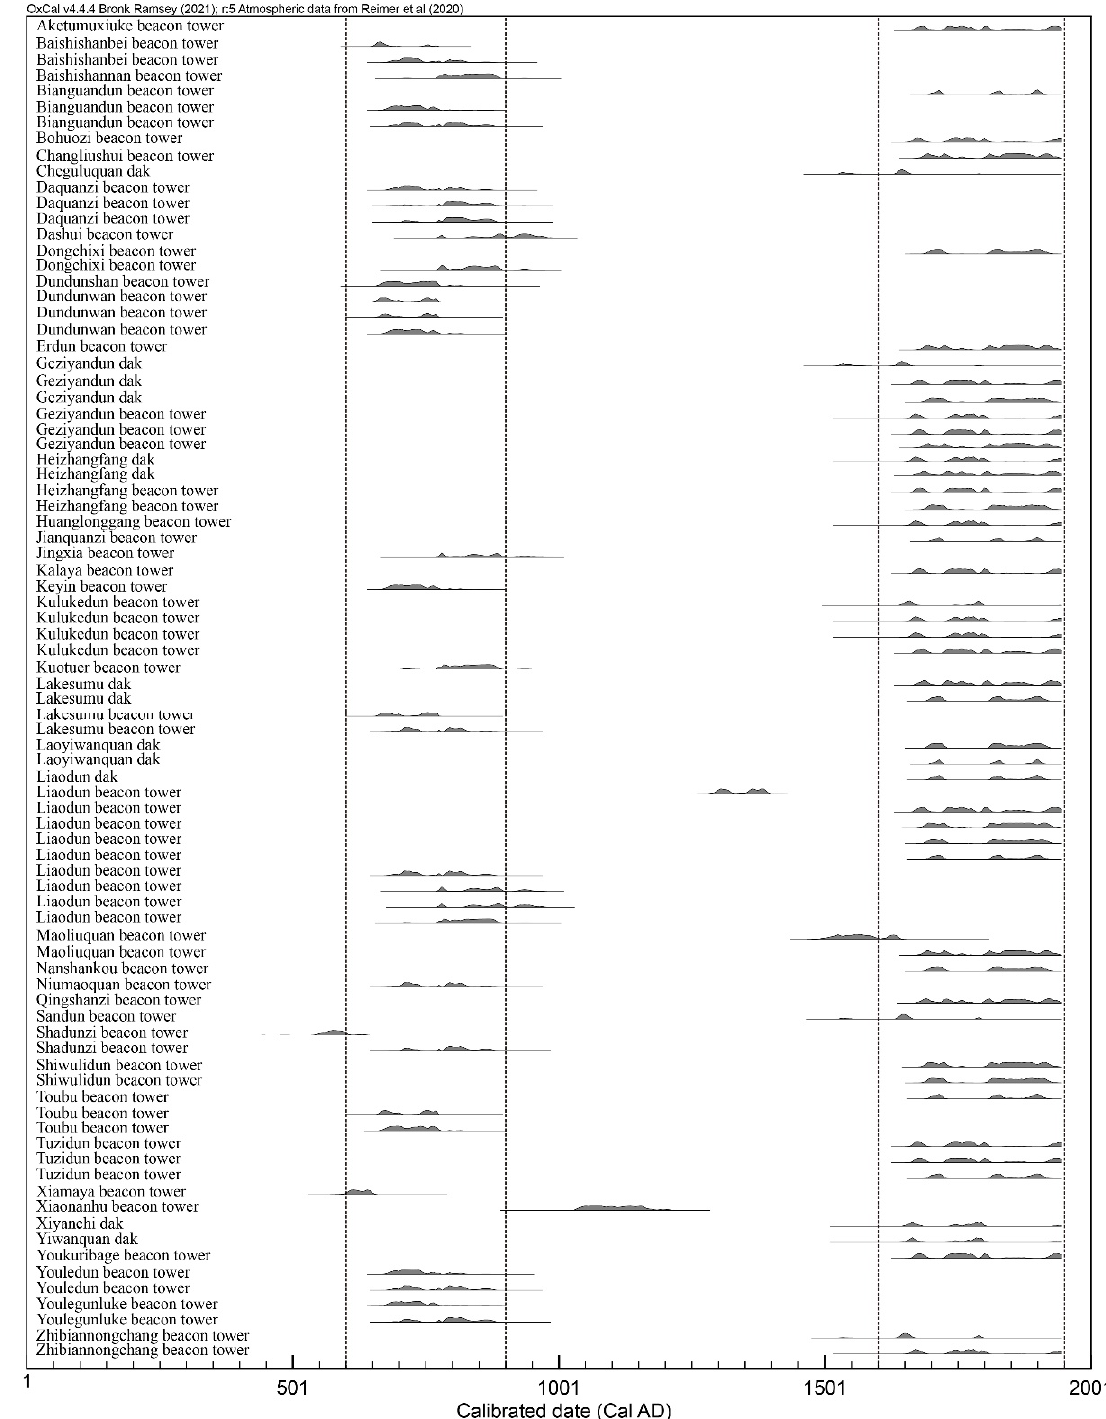
Figure 3. Calibrated dates of beacon towers and dak sites in the eastern Tienshan Mountains.